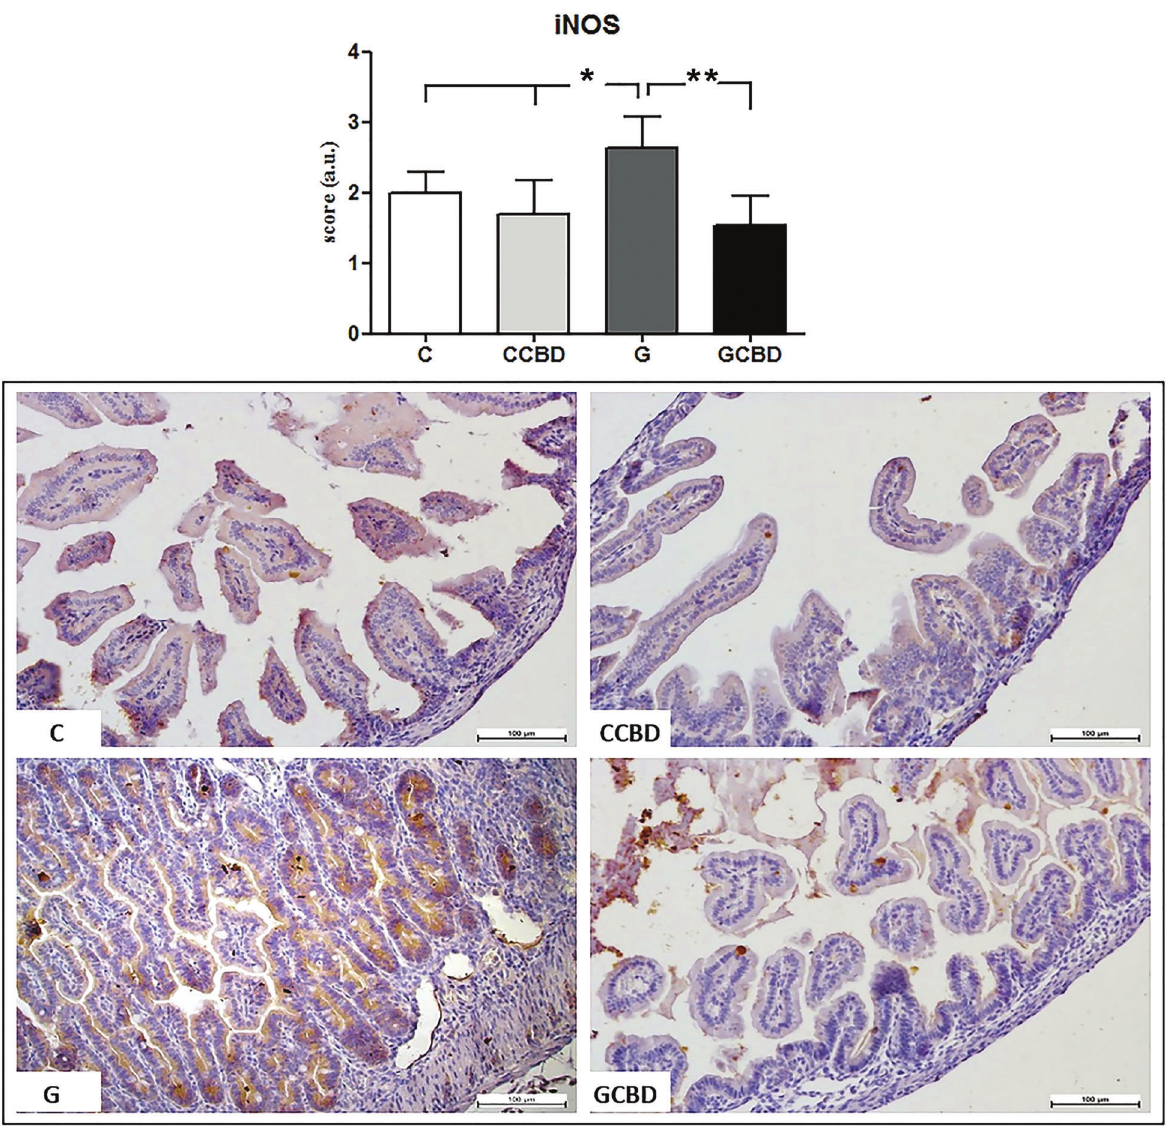
Figure 4. Immunohistochemistry score for iNOS expression and the histological transversal slides stained by immunohistochemistry. Data are reported as means ± SD. Magni fi cation 200 (cid:1) , bar=100 m m. C: control; CCBD: control + cannabidiol; G: gastroschisis; GCBD: gastroschisis + cannabidiol. *P o 0.05; **P o 0.005 (Kruskal